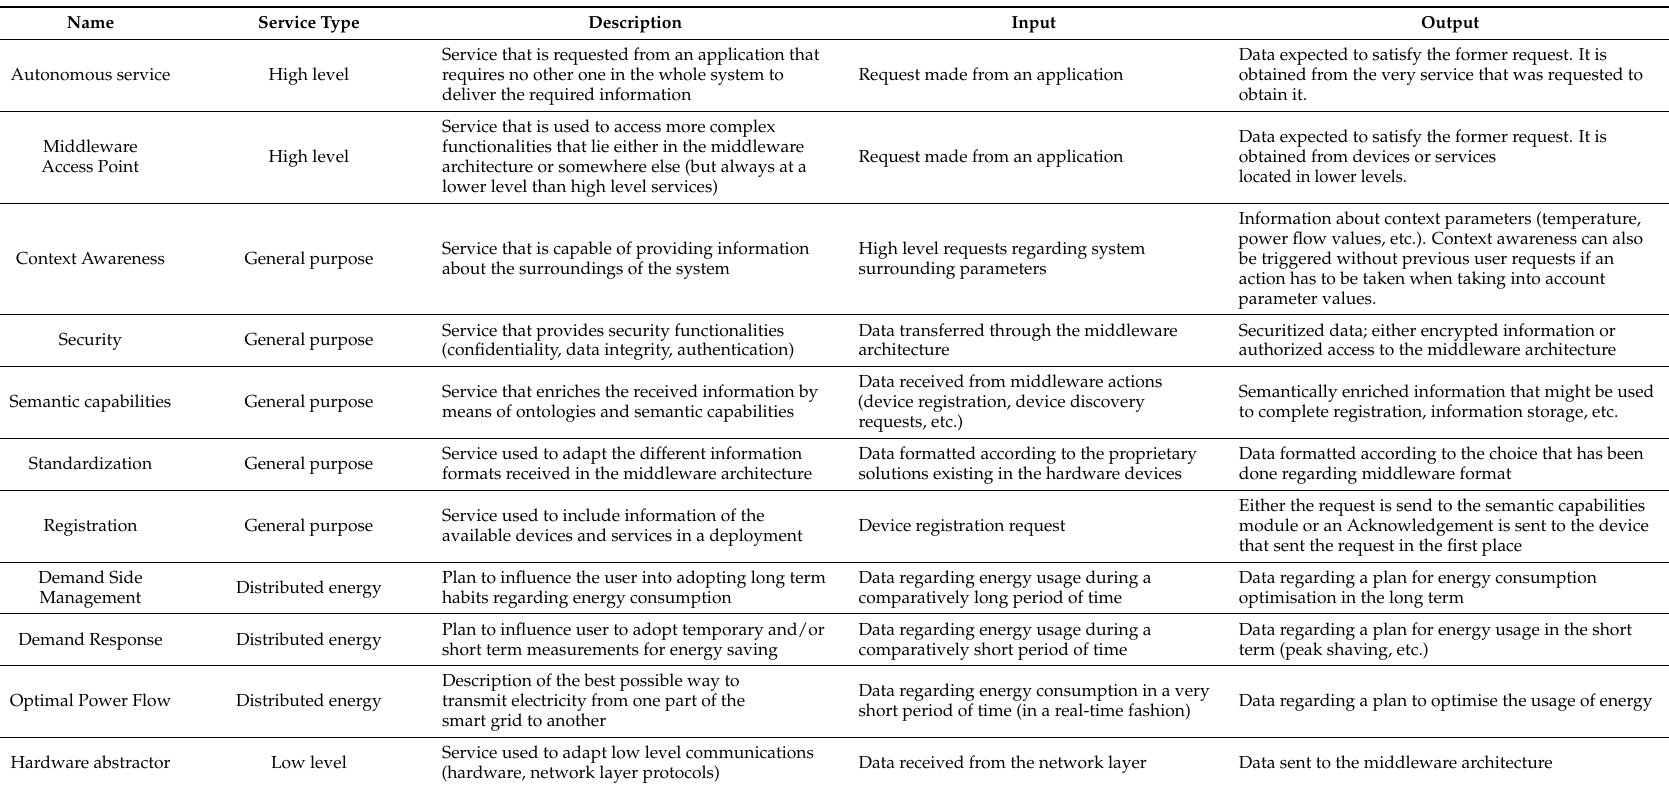
Table 2. Inputs and outputs for each of the